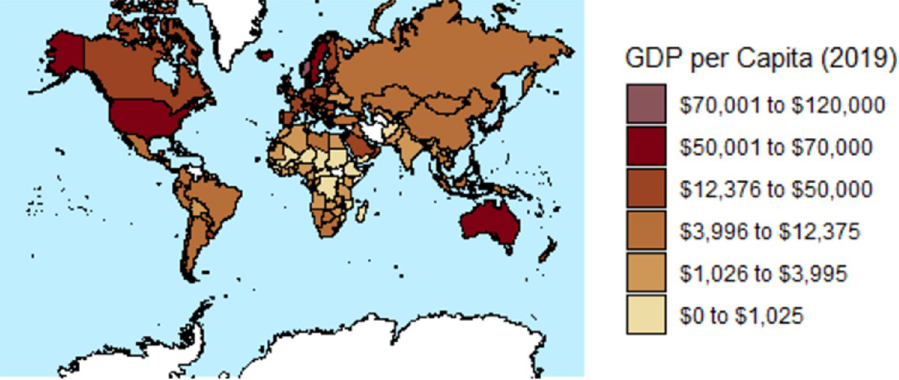
Fig 4. A map of 2019 gross domestic product (GDP) per capita in United States dollars (US $) for 180 countries (map base: [264]).